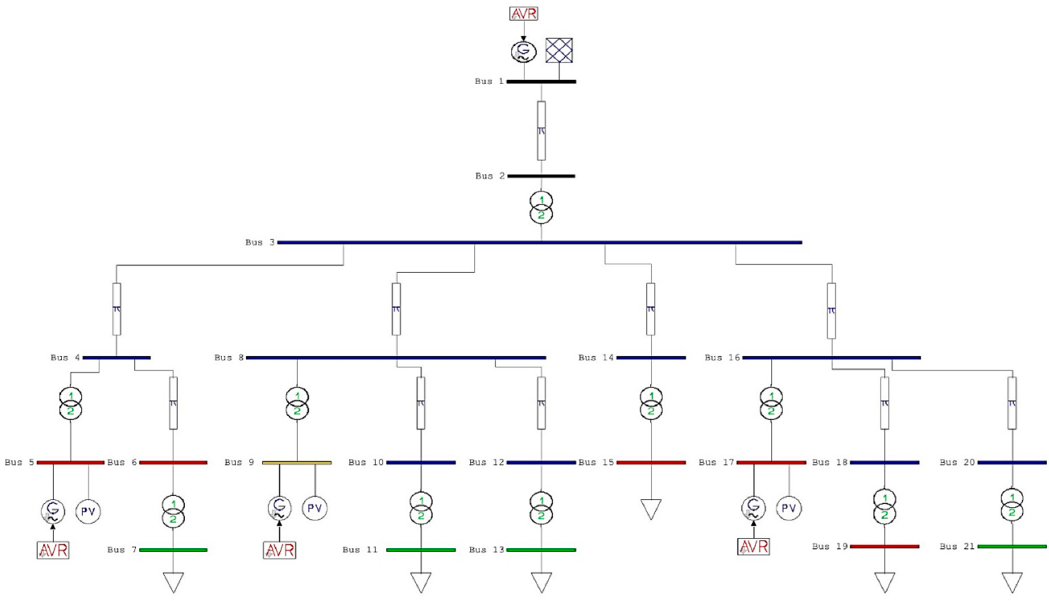
Figure 2. One-line diagram of the IEEE 21-bus microgrid system with synchronous generators implemented in PSAT software.